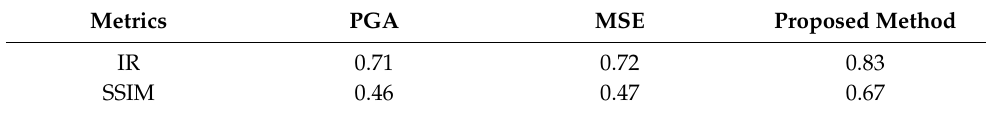
Table 8. The metrics of different methods for the enlarged car area in Figure